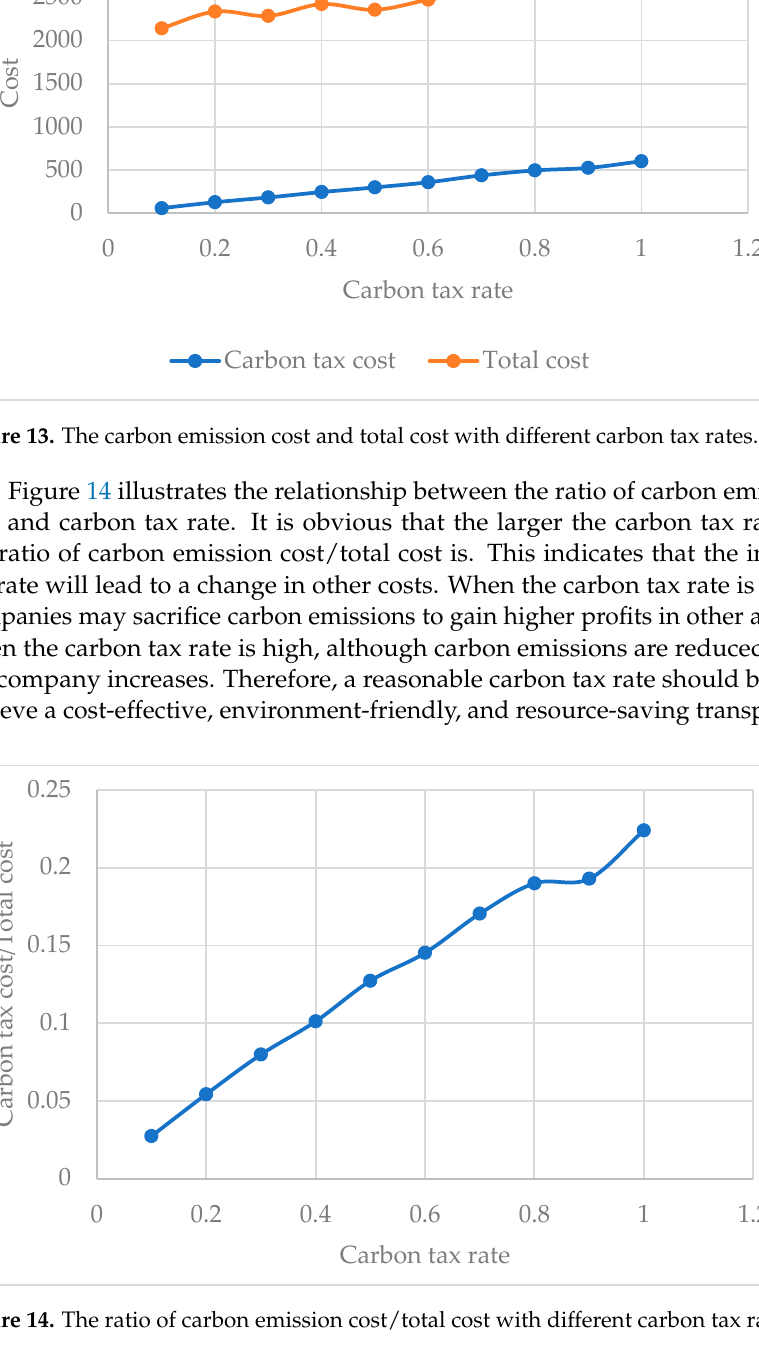
Figure 14. The ratio of carbon emission cost/total cost with different carbon tax rates.